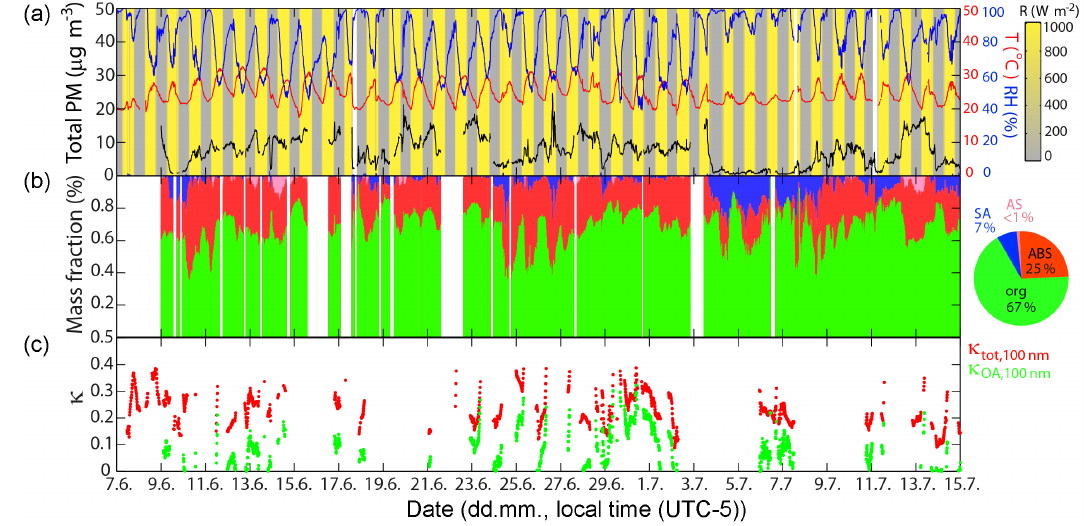
Figure 1. Time series of (a) ambient temperature, RH and PM 1 for the entire campaign; (b) mass fraction of OA (green, average 67%) and stacked mass fractions of inorganics (blue, pink and red; note that blue represents sulfuric acid instead of the usual nitrate in the AMS color scheme); (c) hygroscopicity κ of total particles (red dots) and of OA fraction (green dots). Shaded color in panel (a) represents amount of solar radiation (dark bars denote night and yellow bars denote daytime).